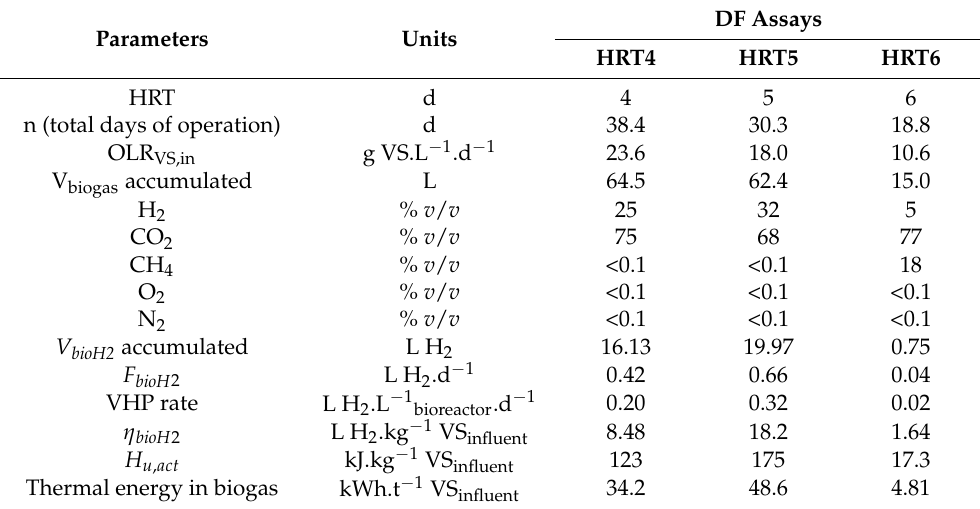
Thermal energy in biogas kWh.t − 1 VS